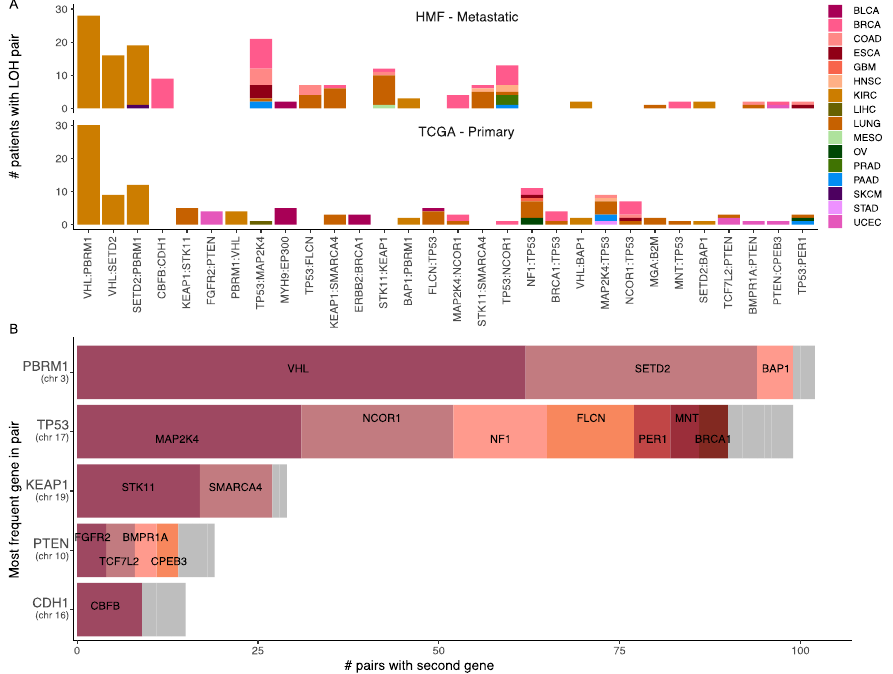
Figure 6. Driver gene pairs in areas of LOH. ( A ) Bar plot showing the pairs of driver genes found in areas of LOH in metastatic (top) and primary (bottom) cancer. ( B ) Stacked barplot showing the partner genes for the five most frequently occurring genes in LOH gene pairs.